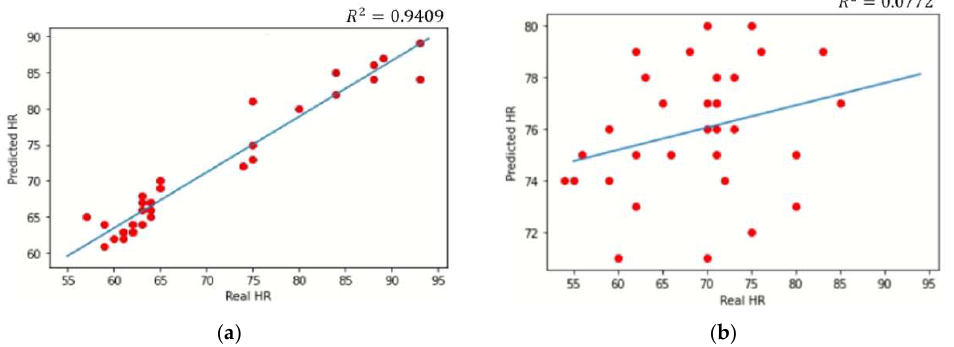
Figure 5. The HR correlation results. ( a ) HR correlation results predicted using the proposed MTS model. ( b ) HR correlation results predicted using the MTTS-CAN model. Scatter plots display the relationship between the HR predictions and their true labels for the proposed MTS model and the other conventional models. MTS produced relatively comparable or even higher correlations for the predictions of HR compared with the other models.